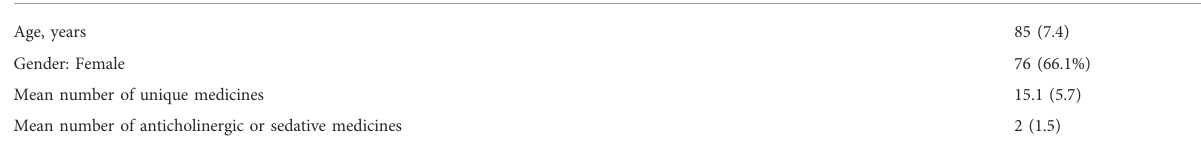
TABLE 1 Baseline characteristics of participants enrolled in the intervention group.